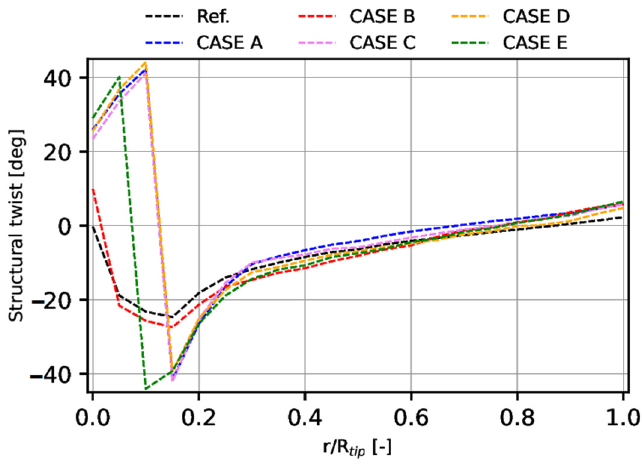
Figure 8. Structural twist distribution of the design configurations.